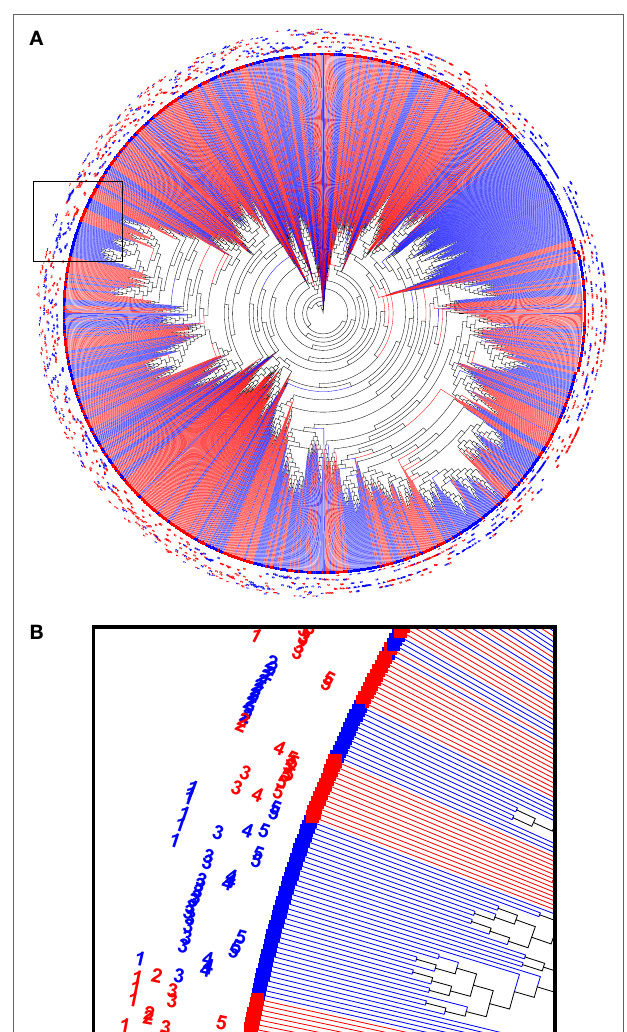
FigUre 5 | A phylogenetic tree computed from a combined set of the 200 most abundant reads from each sample (a) . Nodes from HuD were plotted in red and nodes from DNP-treated animals were plotted in blue, and sample identifiers (1–5) were included in the label. Branches that were homogeneous for the antigen that was used (single color) often contained reads derived from all of the individual animals of that group. The indicated region that was enlarged (B) highlights examples of both mixed sample branches and a single sample (DNP-2)